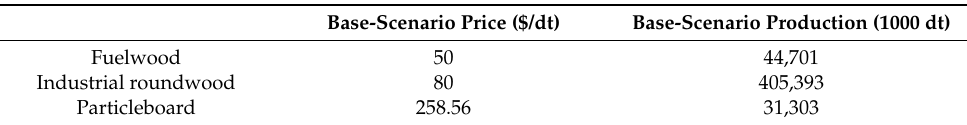
Table 2. Base scenario price and